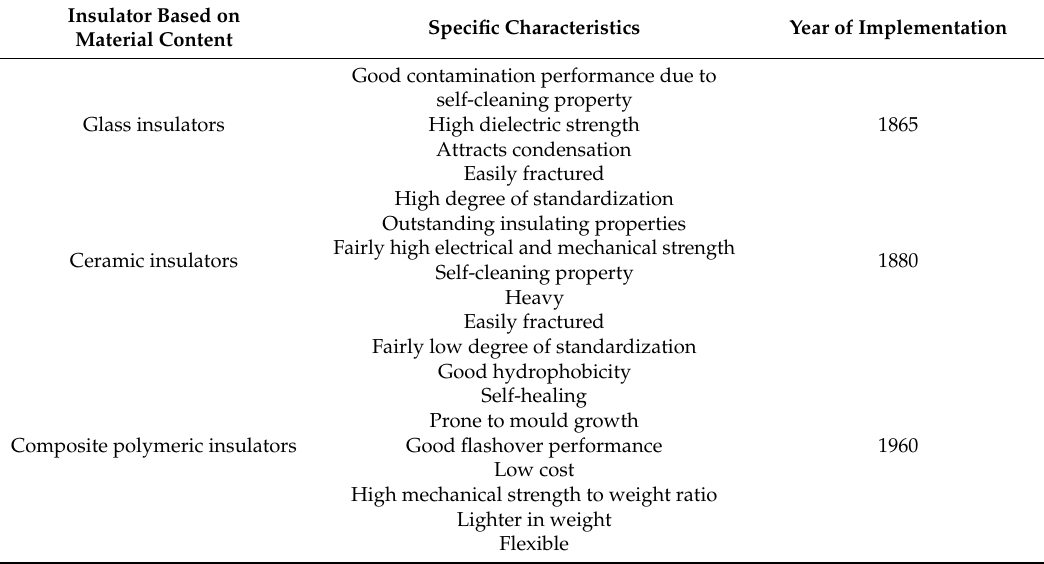
Table 1. Classification of high-voltage (HV) insulators based on their material content, physical and chemical characteristics and year of implementation.